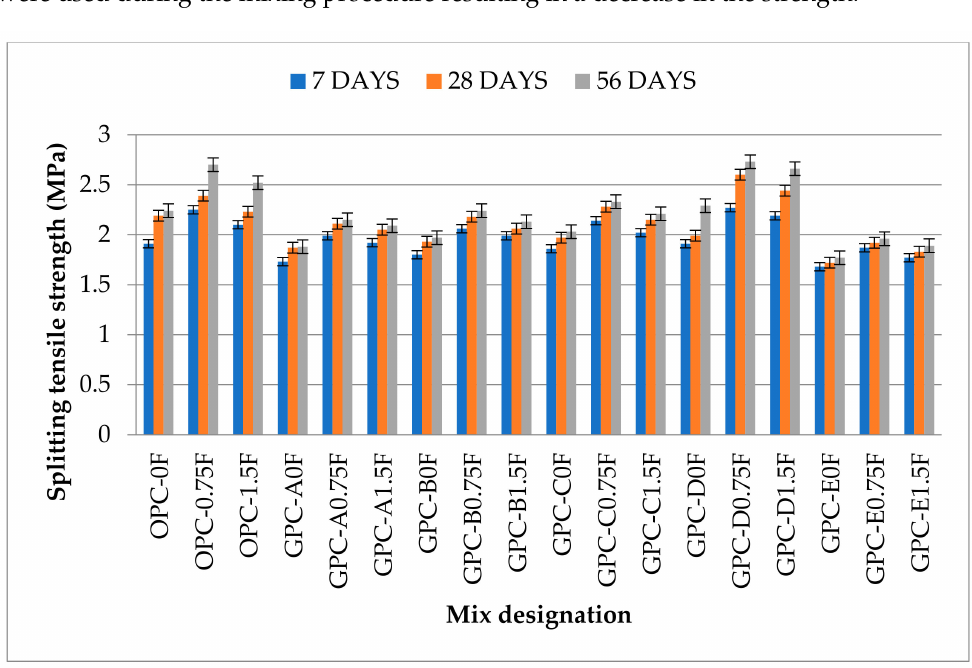
Figure 8. The splitting tensile strength values of GPC and OPC